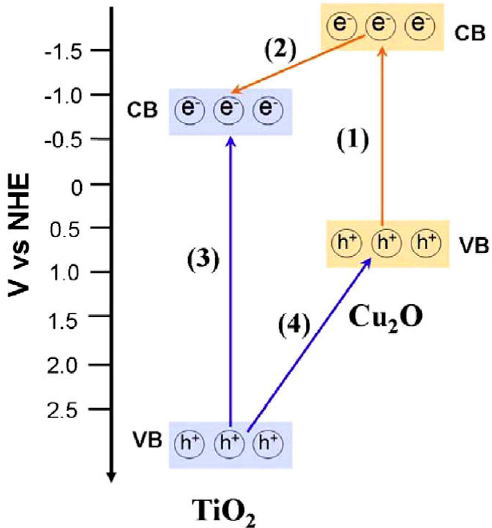
Figure 11. The scheme of excitation and separation of electrons and holes for Cu 2 O/TiO 2 heterostructures under irradiation. Transformations (1) and (3) represent the excitation process in Cu 2 O and TiO 2 , respectively; process (2) and (4) stand for the transfer of electrons and holes between Cu 2 O and TiO 2 ). Transformations (1) and (2) occur both under UV and visible light, while process (3) and (4) under UV light. Reprinted with permission from [95]. Copyright Elsevier, 2009.